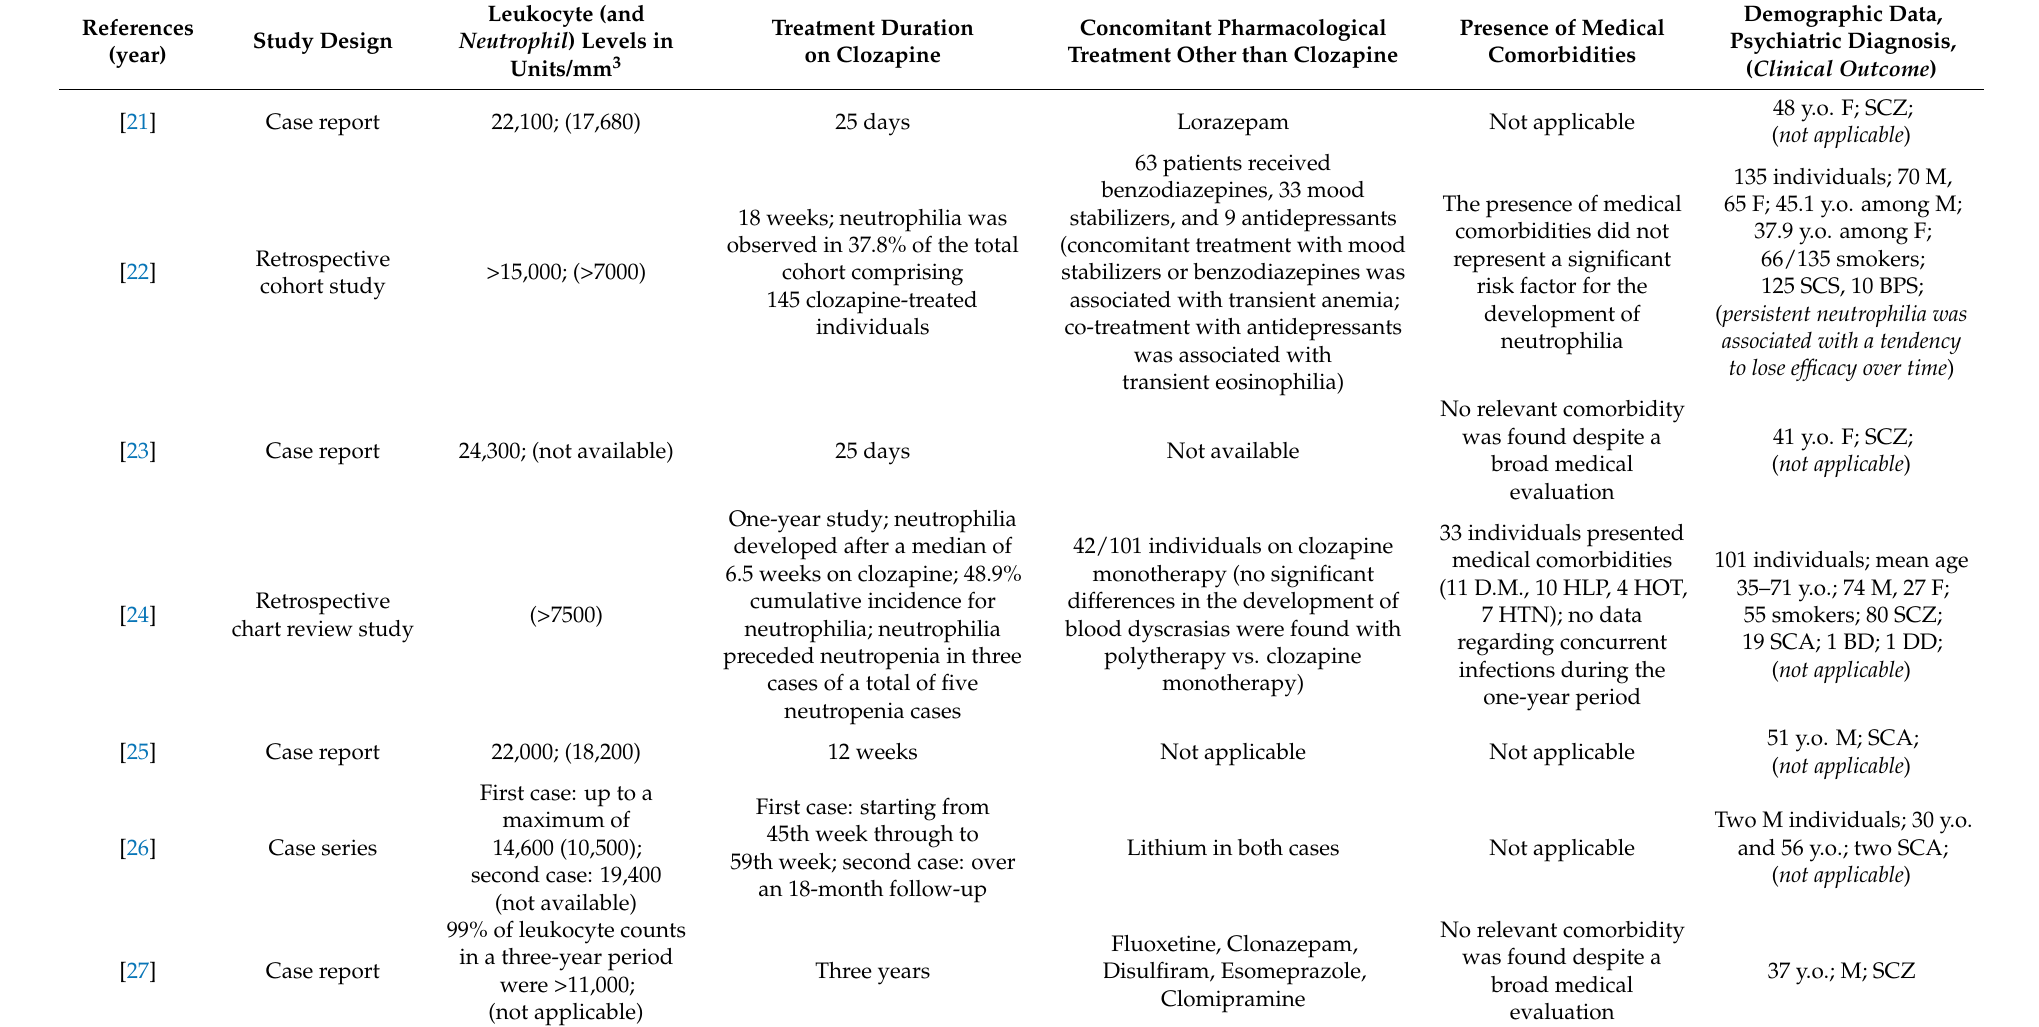
Table 1. Articles retrieved with the systematic